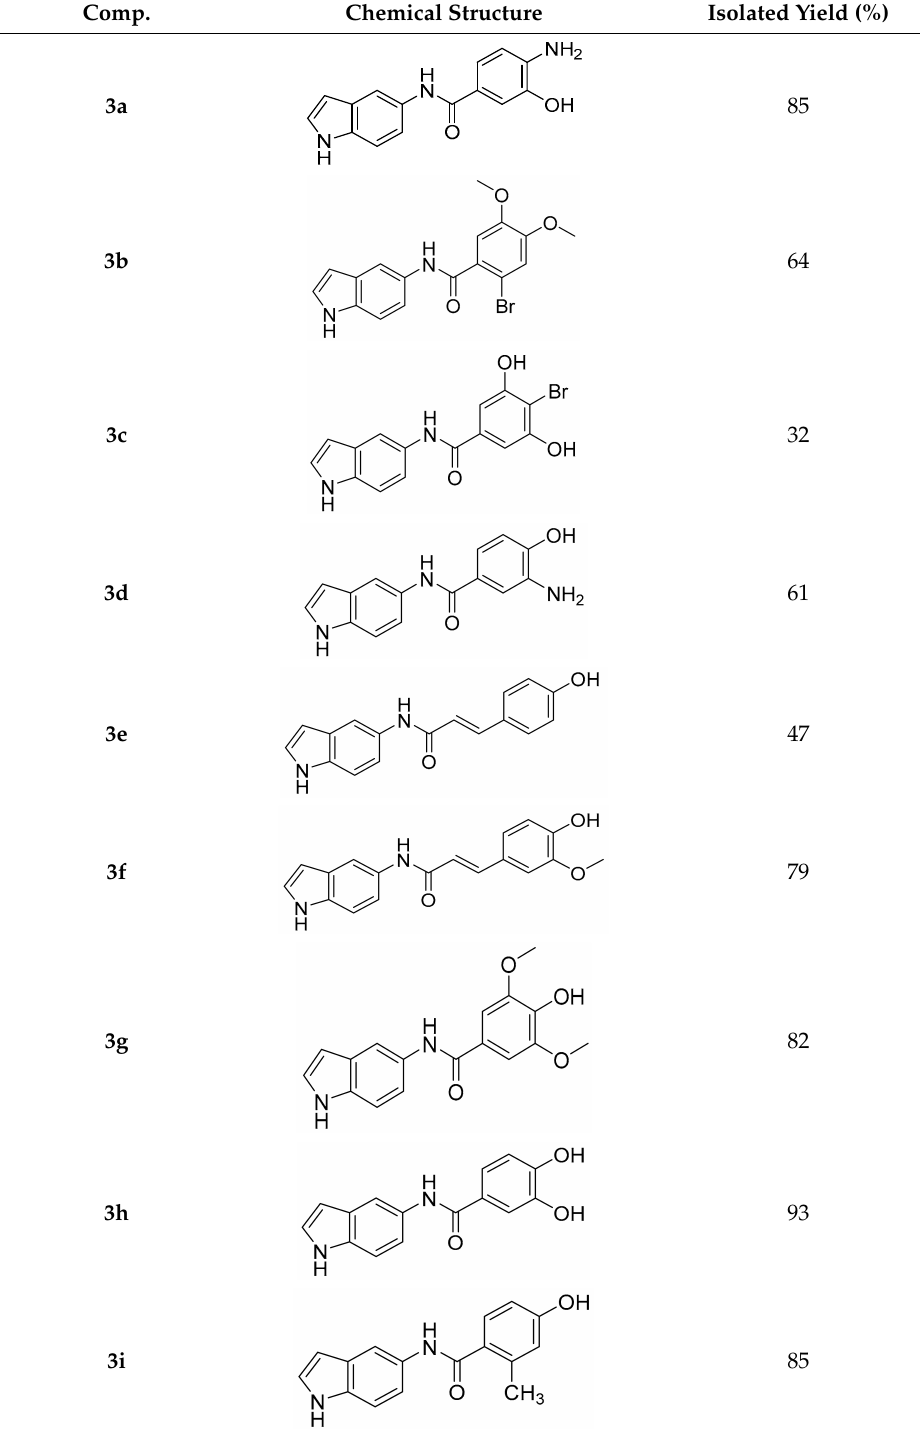
Table 1. Yields and chemical structures of the synthesized analogues 3a – m . Comp.